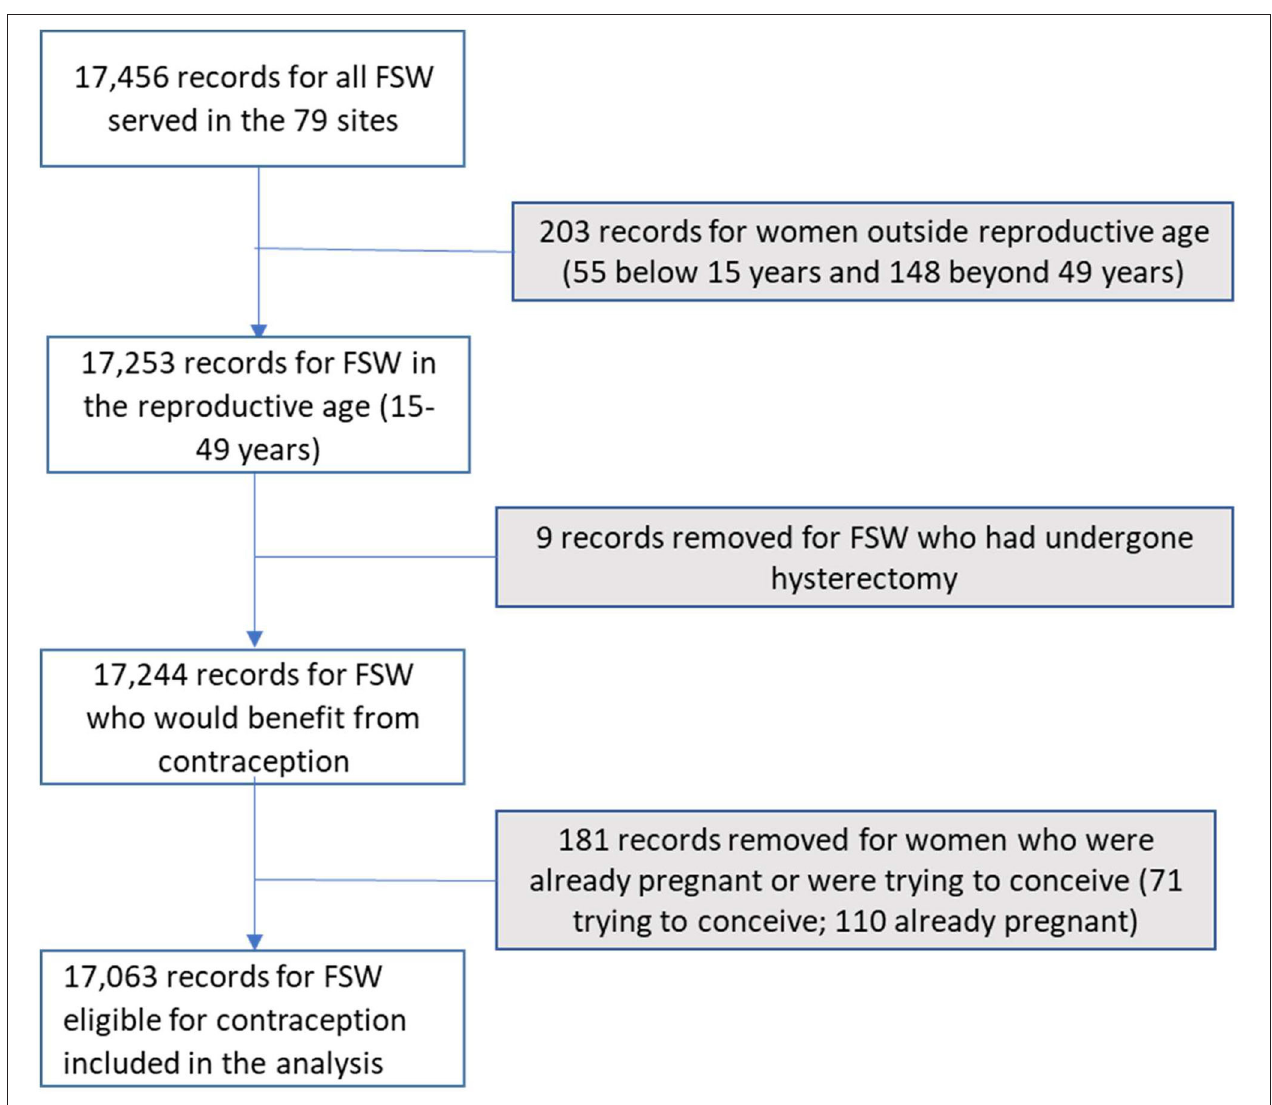
FIGURE 2 | Flow diagram for the number of female sex worker (FSW) records